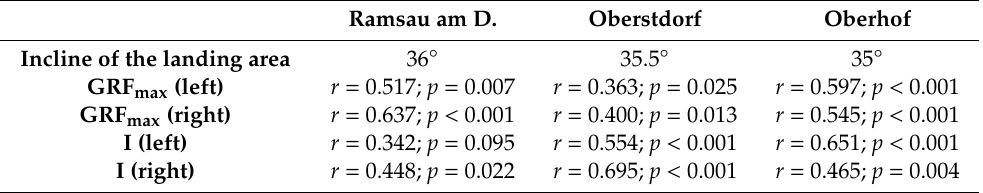
Table 3. Correlations between t flight , and normal GRF max and impulse (I) acting on the left and right foot, in relation to the jumping hills where the data were collected. The landing area incline characterized the jumping hills [44]. Ramsau am D. Oberstdorf